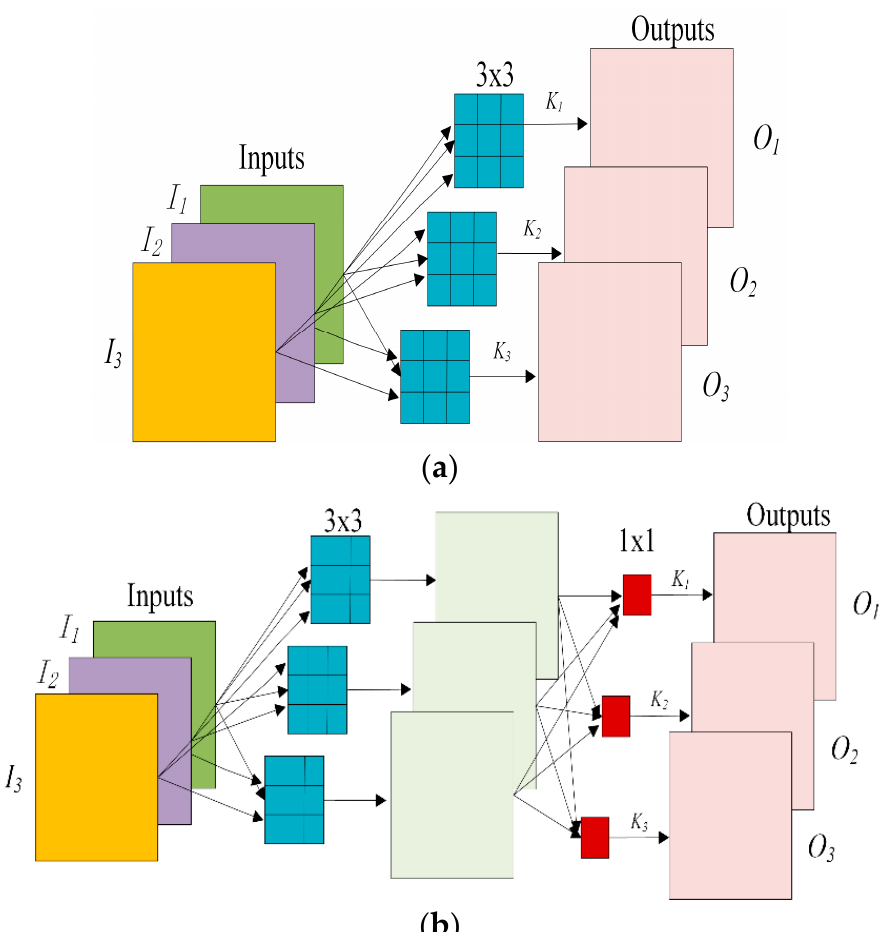
Figure 2. Contrast diagram of ( a ) traditional and ( b ) depthwise separable convolutions. Suppose the dimensions of the input matrix are N F × D F × D F × C F , the traditional convolutional kernel size is N K × D K × D K × C K , and the two convolutional kernel sizes in the depthwise separable convolution are C F × D K × D K × 1, N F × 1 × 1 × C K . The calculation amounts of traditional and depthwise separable convolutions are shown in Formulas (1) and (2),